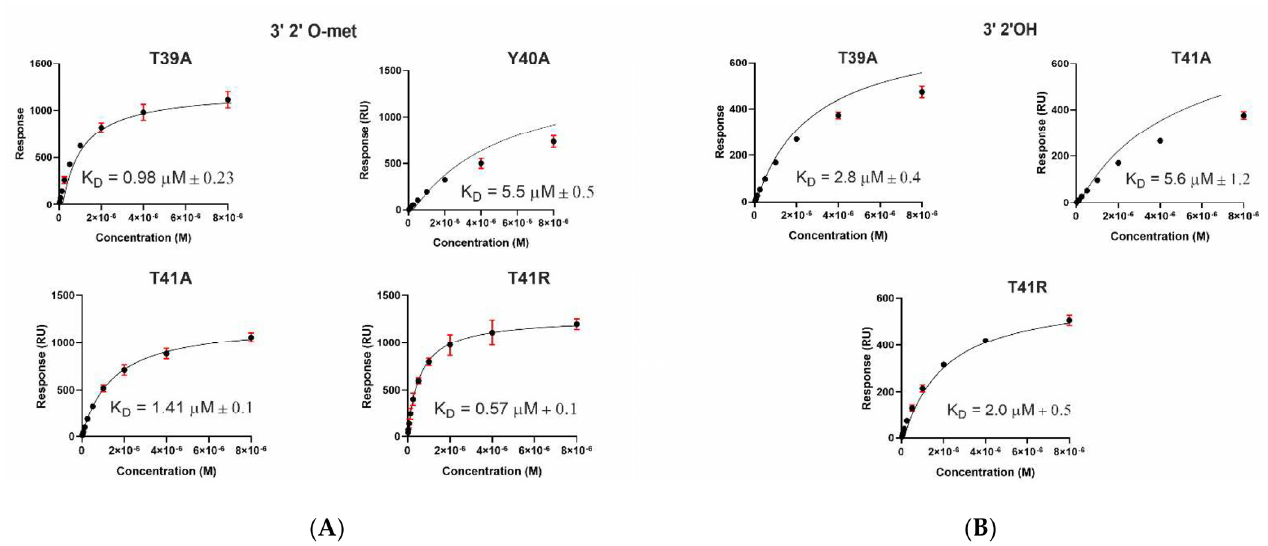
Figure 3. Affinity-binding equilibrium curves for AePiwi4 PAZ mutants to piRNAs. Fitted affinity-binding equilibrium curves for AePiwi4 PAZ mutant analytes to a 28 nt ( A ) 3 ′ 2 ′ O-methylated or ( B ) non-methylated piRNA. Equilibrium K D was calculated from steady-state binding levels R eq = (CR max )/(K D + C) + offset, where C = concentration, R max = analyte- binding capacity of the surface in response units (RU), K D = dissociation constant, and offset = response at zero analyte concentration. M = molar concentration. Red bars indicate mean and standard deviation for R max values.